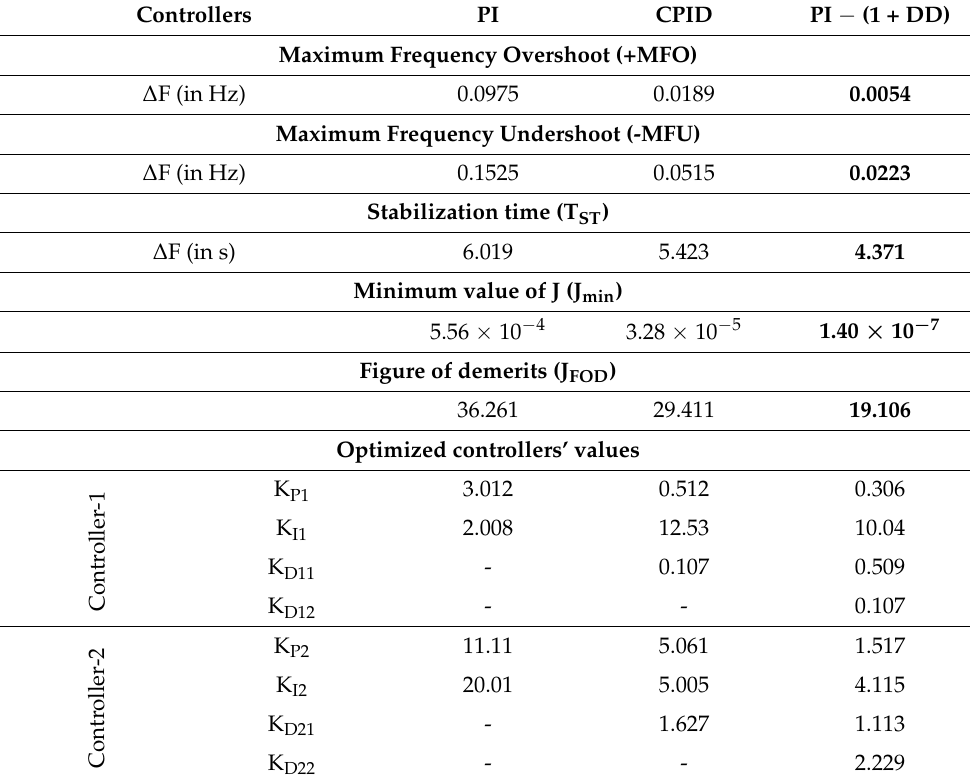
Table 2. Controllers’ gains with comparative performance parameters under 100 iterations.